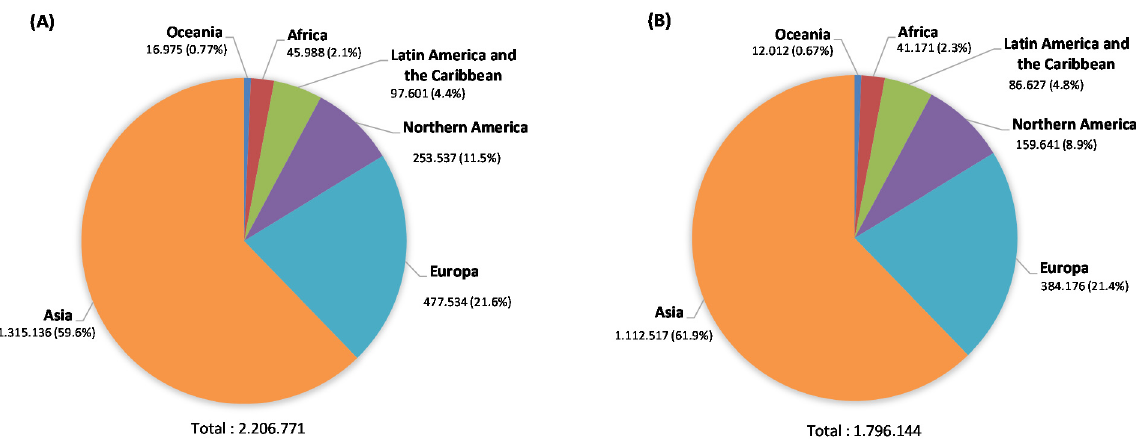
Figure 1. Estimated number of LC new cases in 2020 in both sexes and all ages ( A ) and estimated number of deaths ( B ) (data source: Globocan2020 [1]).